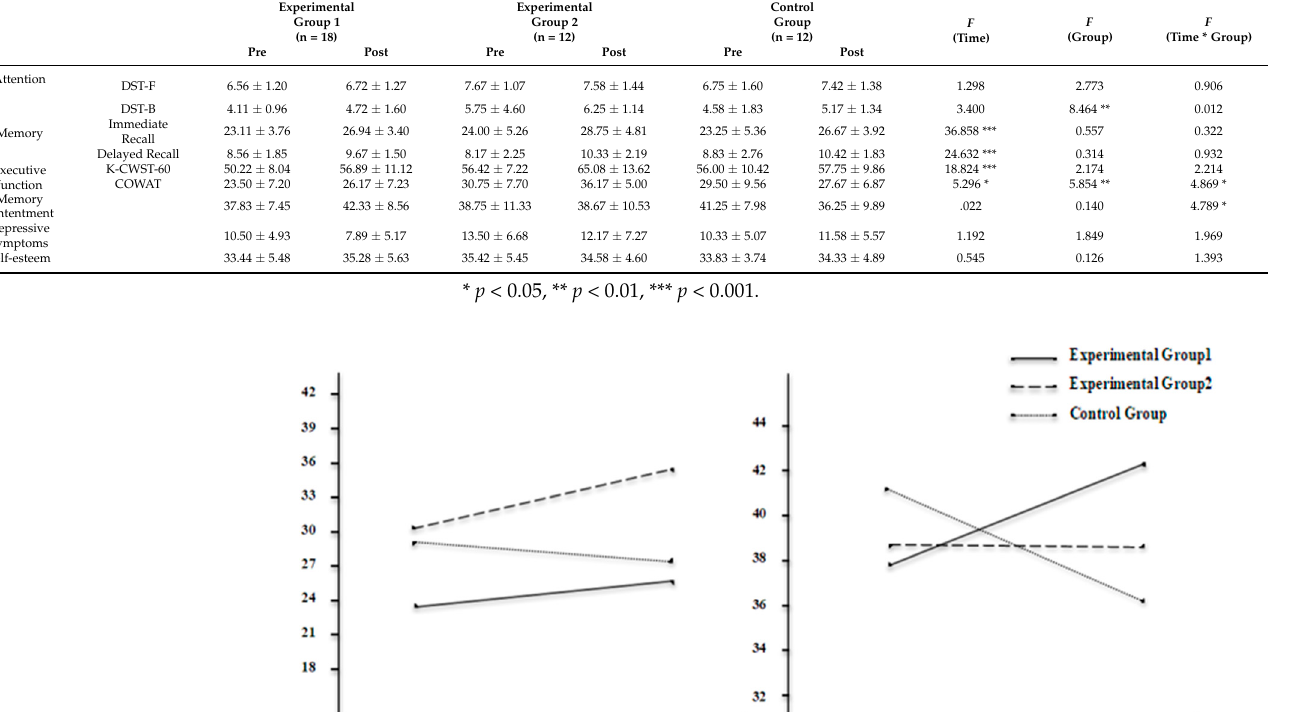
Experimental Group2 (n=12)